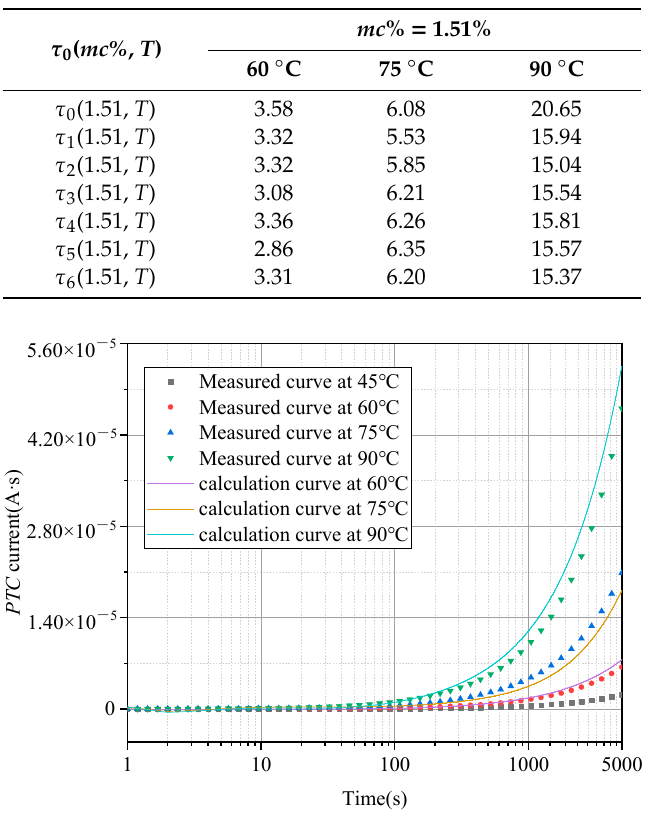
Table 7. Calculation result of the normalized parameters of verification sample.